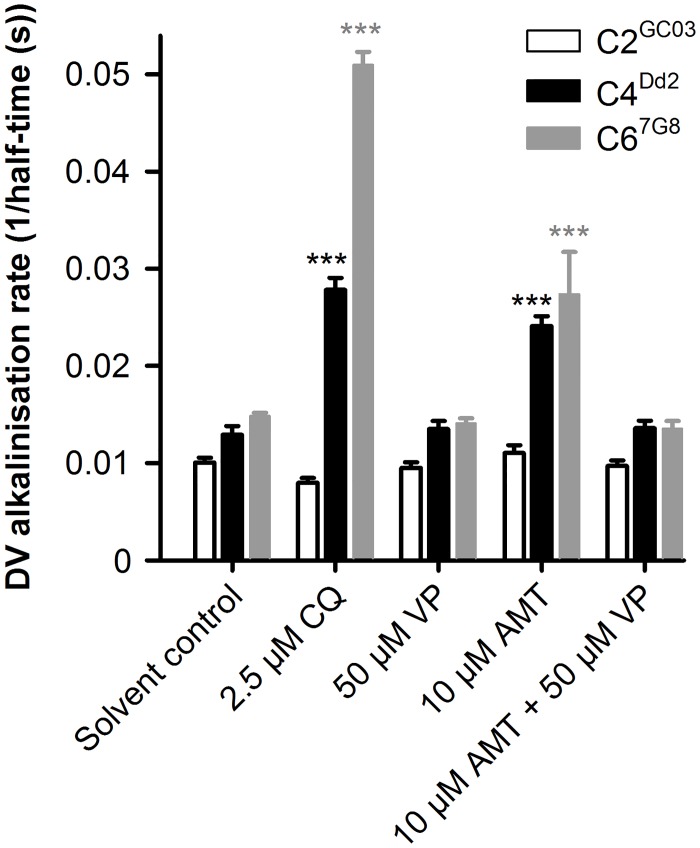
Amantadine is a substrate of PfCRTDd2 and PfCRT7G8, and not of wild-type PfCRT, in situ.The rate of concanamycin A-induced DV alkalinization (expressed as the inverse of the half-time for DV alkalinization) in the C2GC03 (CQ-sensitive, expressing PfCRT3D7), C4Dd2 (CQ-resistant, expressing PfCRTDd2), and C67G8 (CQ-resistant, expressing PfCRT7G8) transfectant lines was measured in the absence and presence of amantadine (AMT), CQ, or verapamil (VP). The effect of amantadine on the DV alkalinization rate was also measured in the presence of verapamil (final concentration of 50 μM). The drugs were added to suspensions of saponin-isolated trophozoite-stage parasites containing fluorescein-dextran in their DVs 4 min before the addition of concanamycin A (100 nM). CQ was added at a concentration of 2.5 μM and the concentration of amantadine was 10 μM. Consistent with previous studies, the addition of CQ elevated the rate of alkalinization in both of the CQ-resistant lines and had a small buffering effect in the C2GC03 parasites [34–36, 46]. The biological basis for the difference in the rate of CQ-dependent alkalinization between the two CQ-resistant lines is currently unclear, but could be due to differences in (1) the expression of PfCRT, (2) the transport properties of the two PfCRT isoforms, (3) the volume of the DV, and/or (4) the concentration of PfCRT’s natural substrates within the DV. The data are the mean + SEM of five independent experiments (performed on different days). The asterisks denote a significant difference from the relevant solvent control: ***P < 0.001 (one-way ANOVA).